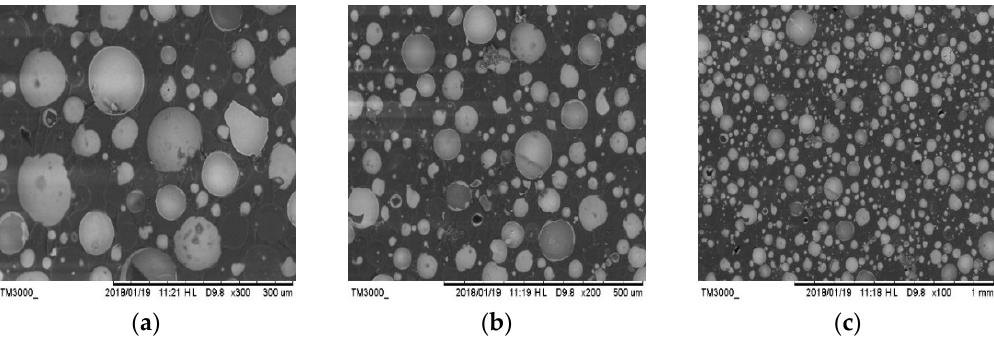
Figure 8. The cross-sectional morphology of AG-80 epoxy resin-based buoyancy material with 55% volume fraction of HGM. ( a ) The cross section of the No.5 sample is magnified 300 times. ( b ) The cross section of the No.5 sample is magnified 200 times. ( c ) The cross section of the No.5 sample is magnified 100 times.